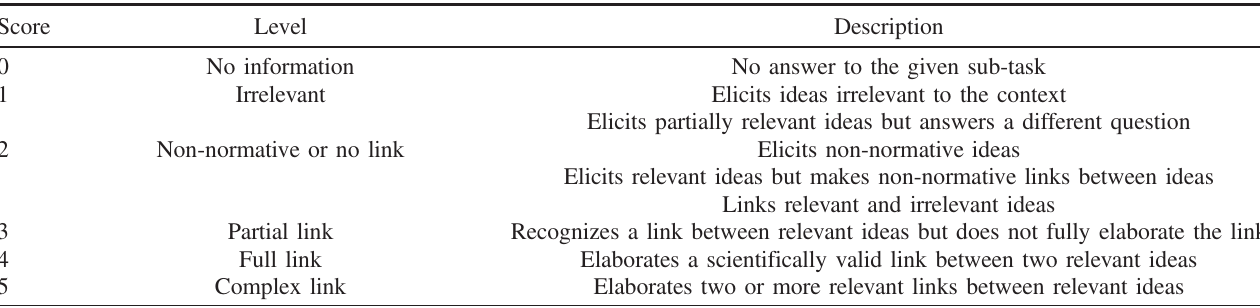
TABLE II. KI rubric used to grade answers to each subtask.